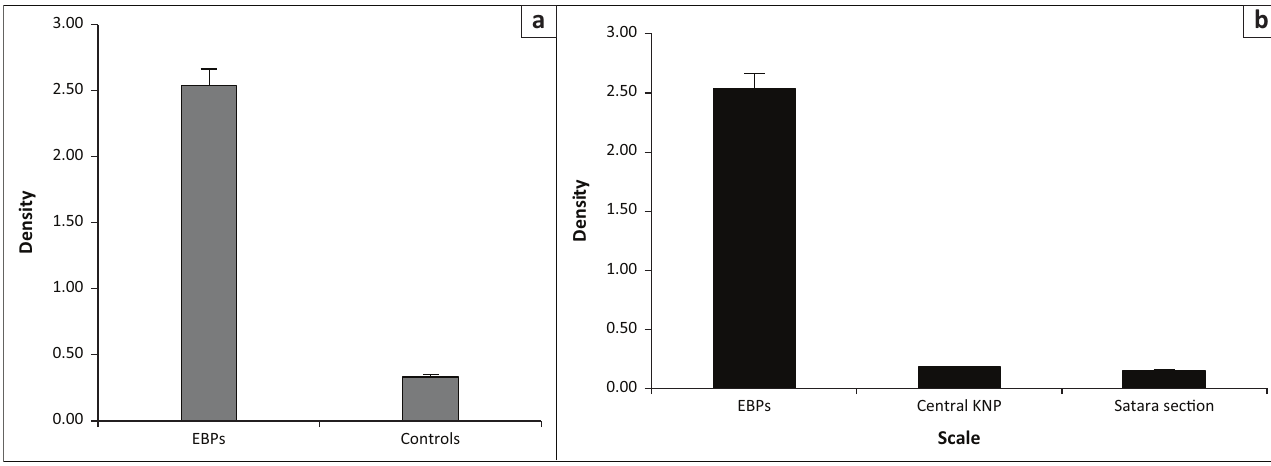
strings than the non-manipulated control areas